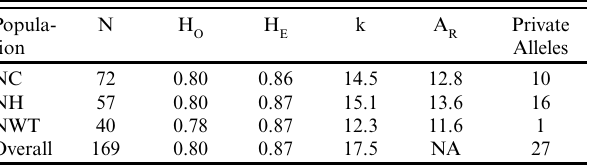
Table 2 . Number of individuals genotyped (N), observed heterozygosity (H ), expected heterozygosity (H O of alleles per locus (k), and private alleles.